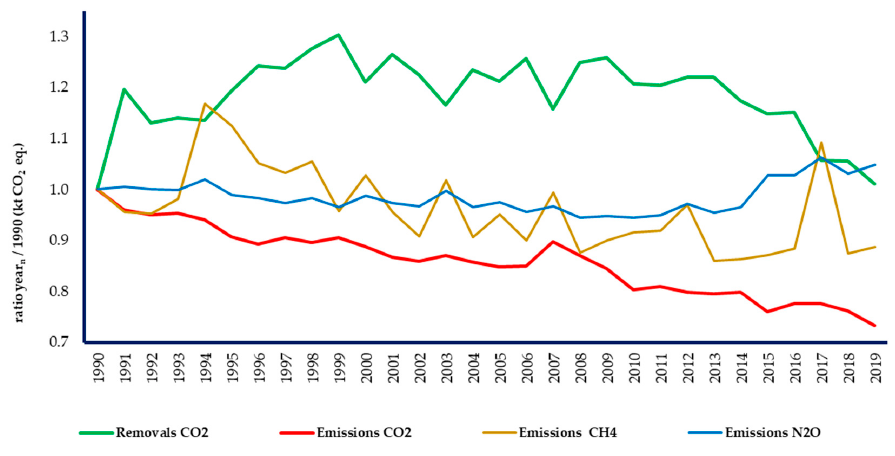
Figure 1. GHG emissions vs. GHG removals comparative dynamics, EU-27 + UK . Basically, the GHG emissions decreased by 23% in 2019 compared to 1990. From 390,000 kt CO 2 eq. in 1990, the GHG removals had a smooth increase, to 394,000 kt CO 2 eq. in 2019, about 1.1% over time.